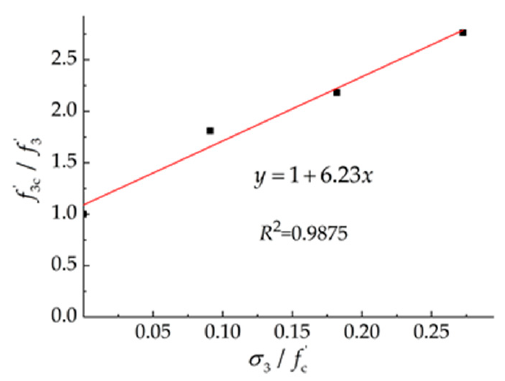
Figure 14. Mohr-Coulomb criterion.